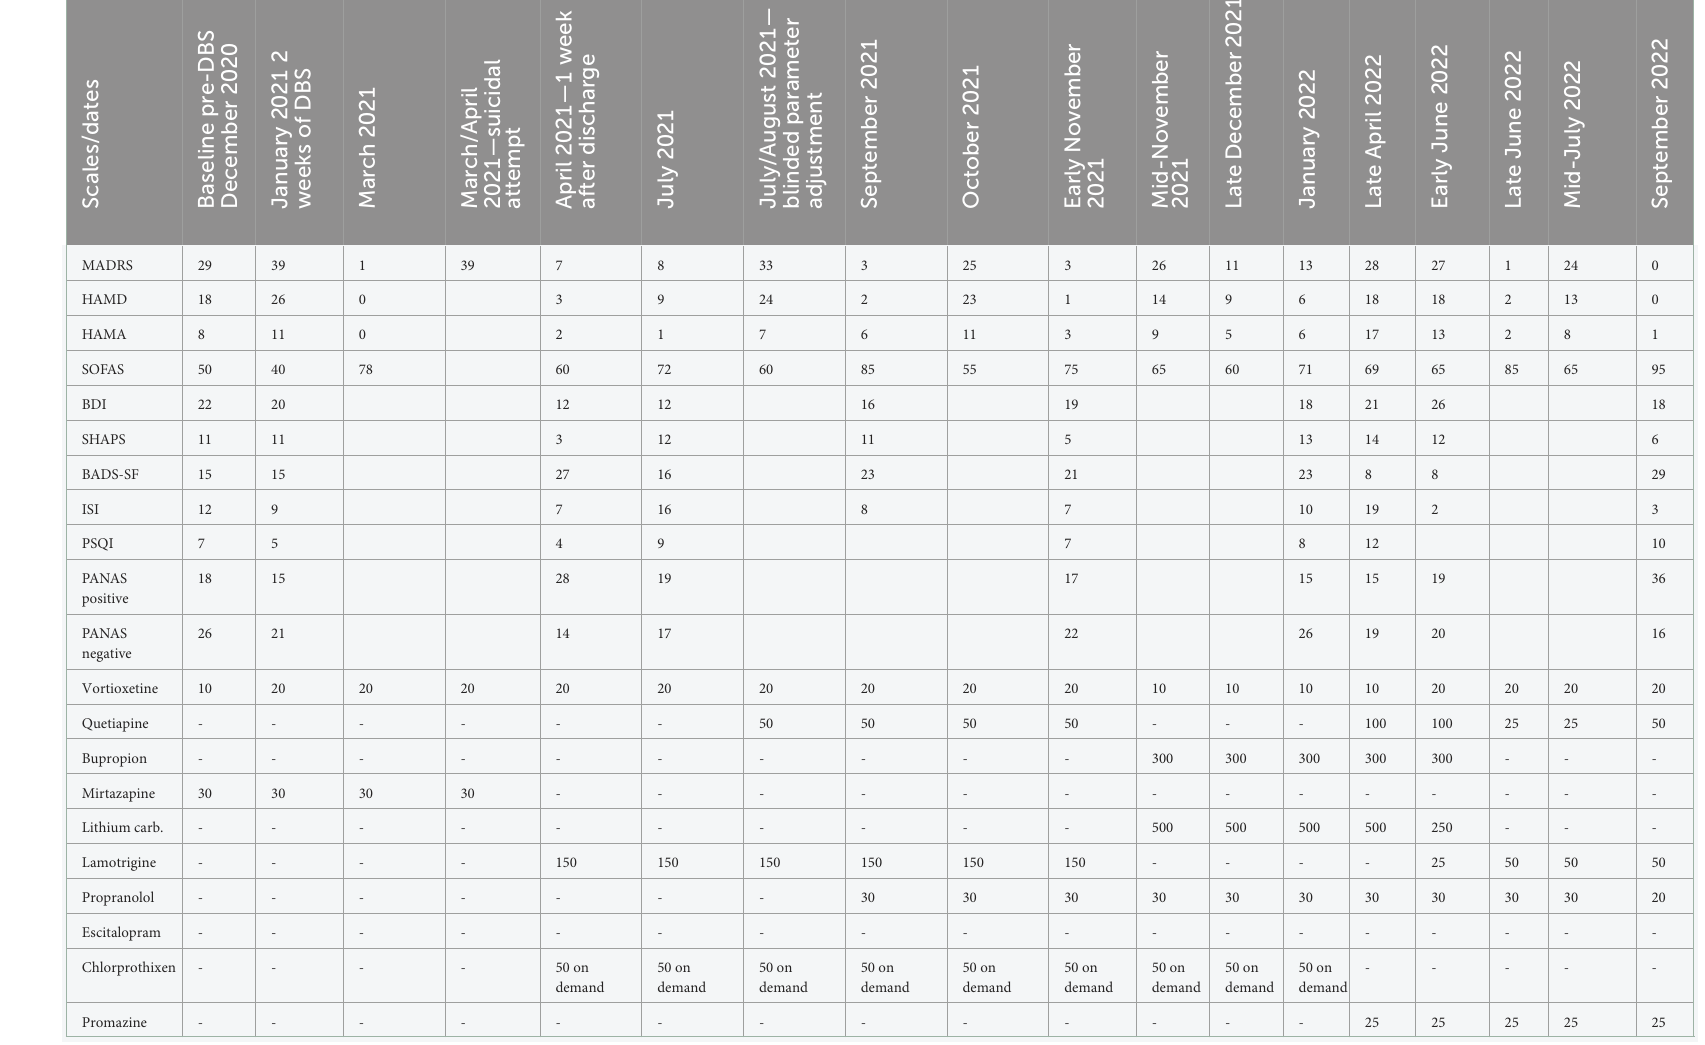
TABLE 2 The most important information on therapeutic intervention (MFB DBS combined with psychotherapy and pharmacotherapy) of TRD case